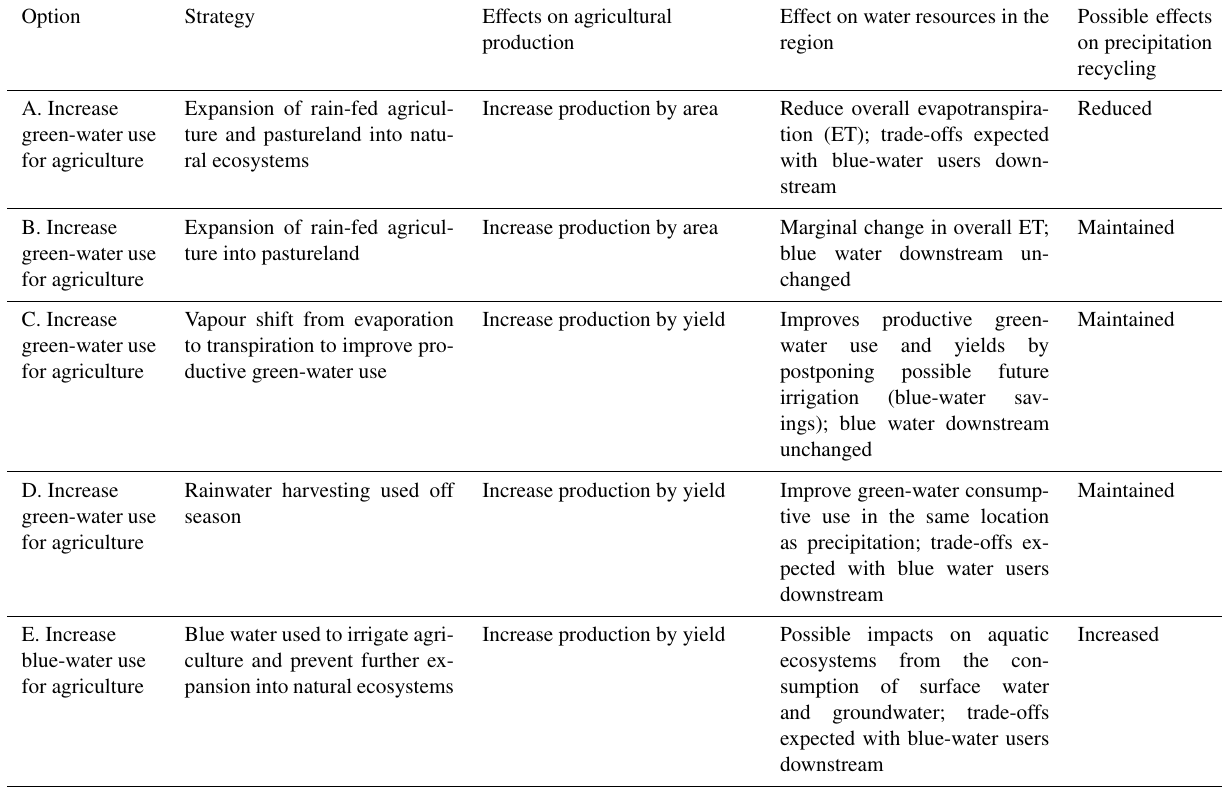
Table 4. Green- and blue-water use options to increase agricultural production in south-eastern Amazonia with possible trade-offs in water resources and regional precipitation